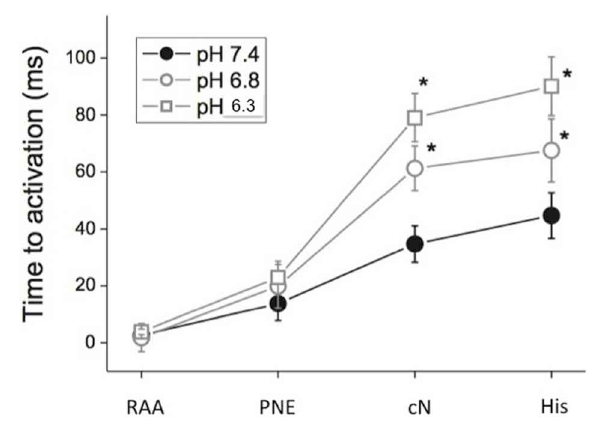
FIGURE 4 | Time to activation (Mean ± s.e.m. ms) relative to the atrial electrogram at pH 7.4, 6.8, and 6.3 and PCL 300ms. (RAA, right atrial appendage; PNE, posterior nodal extension; cN, compact AVN; His, His bundle region). n = 3 at each